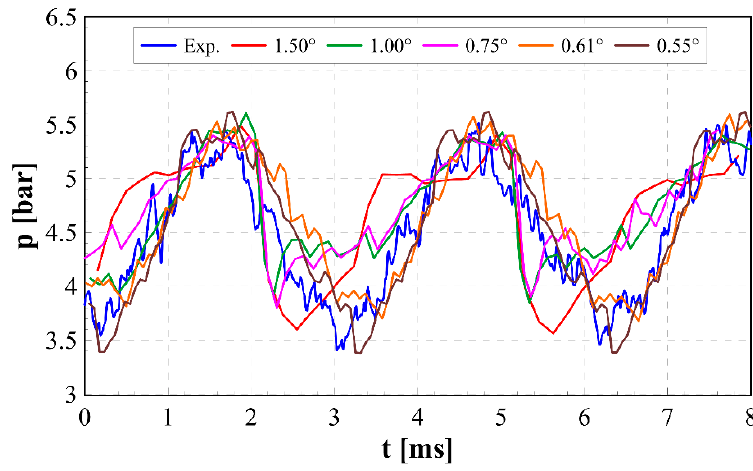
Figure 5. Influence of the angular step on the delivery pressure. Table 2. Parameters of the mesh. Number of elements 1,608,091 Number of cells rotor (circumferential direction) 2880 Number of cells rotor (radial